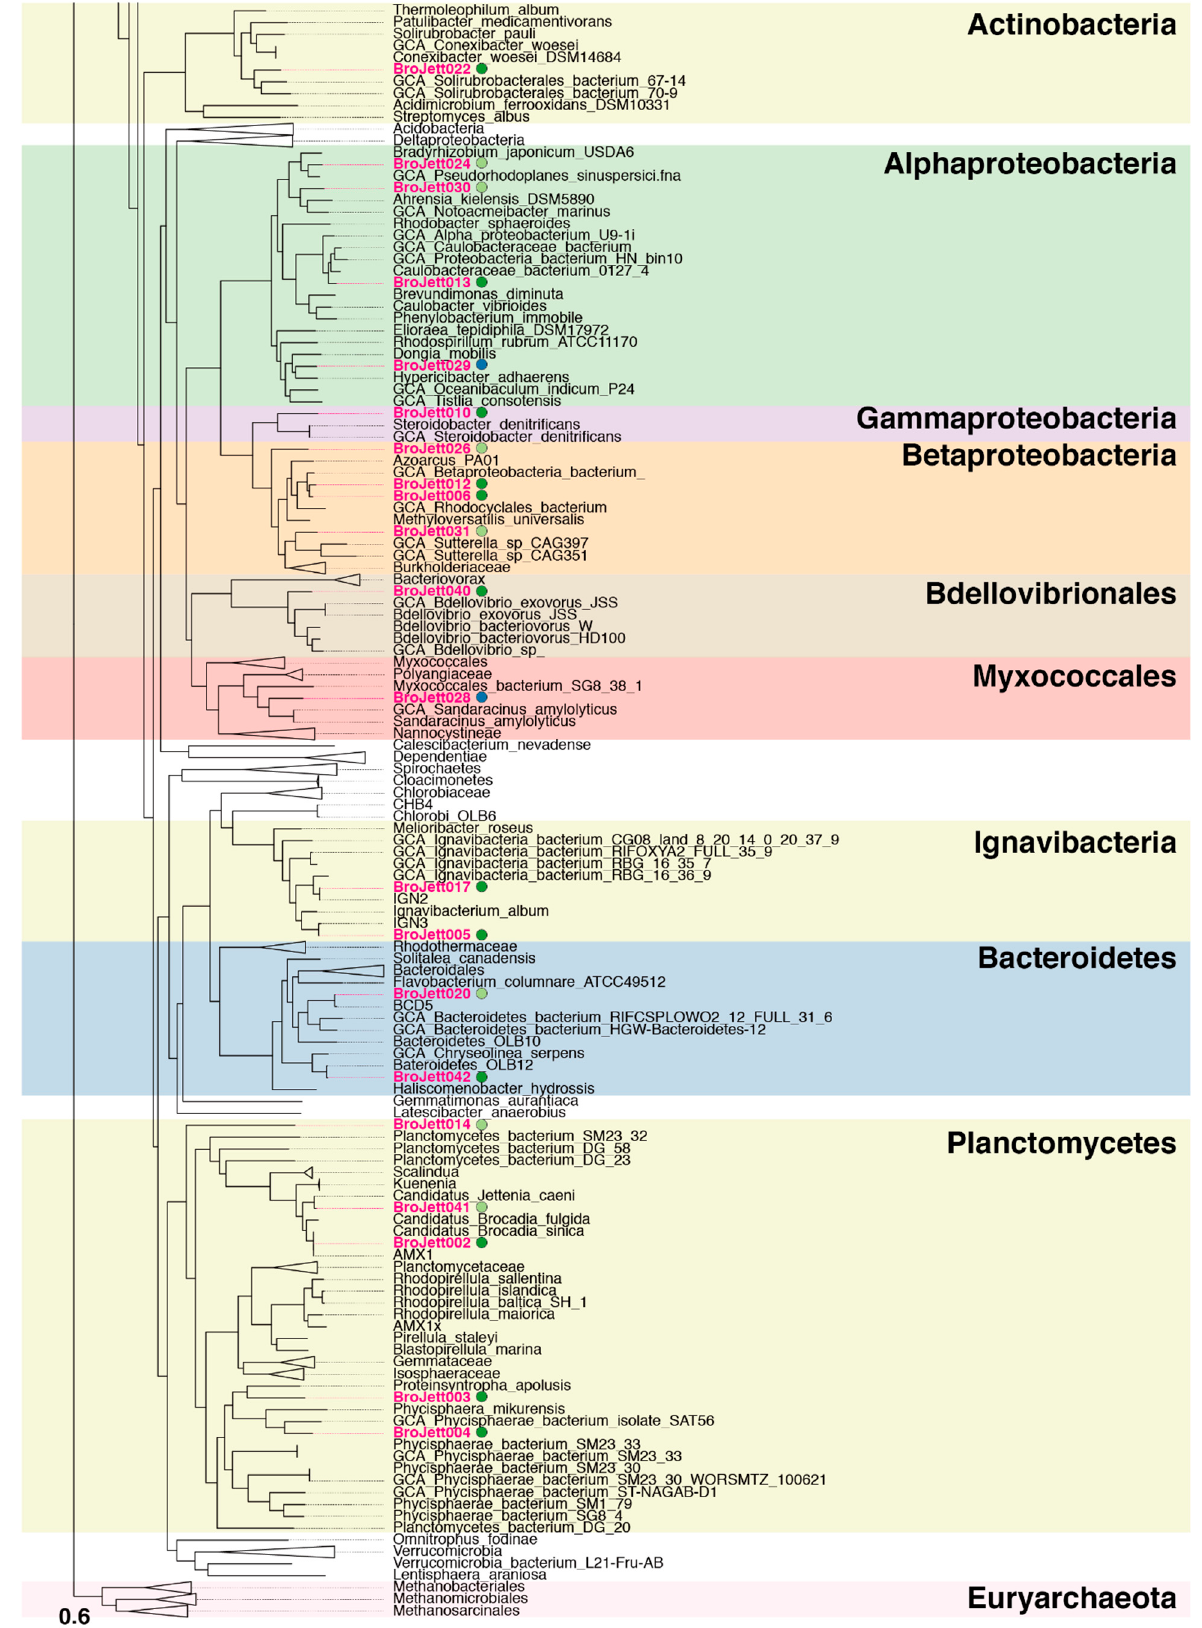
Figure 2. Phylogenetic tree of bins and related genomes. The bins found in this study are shown in bold. BroJett033 and BroJett039 had low completeness and are represented in a bold black font.